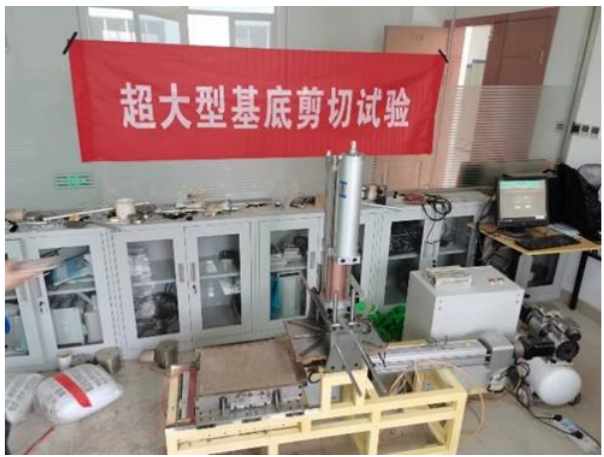
Figure 6. Ultra-large interface shearing equipment.